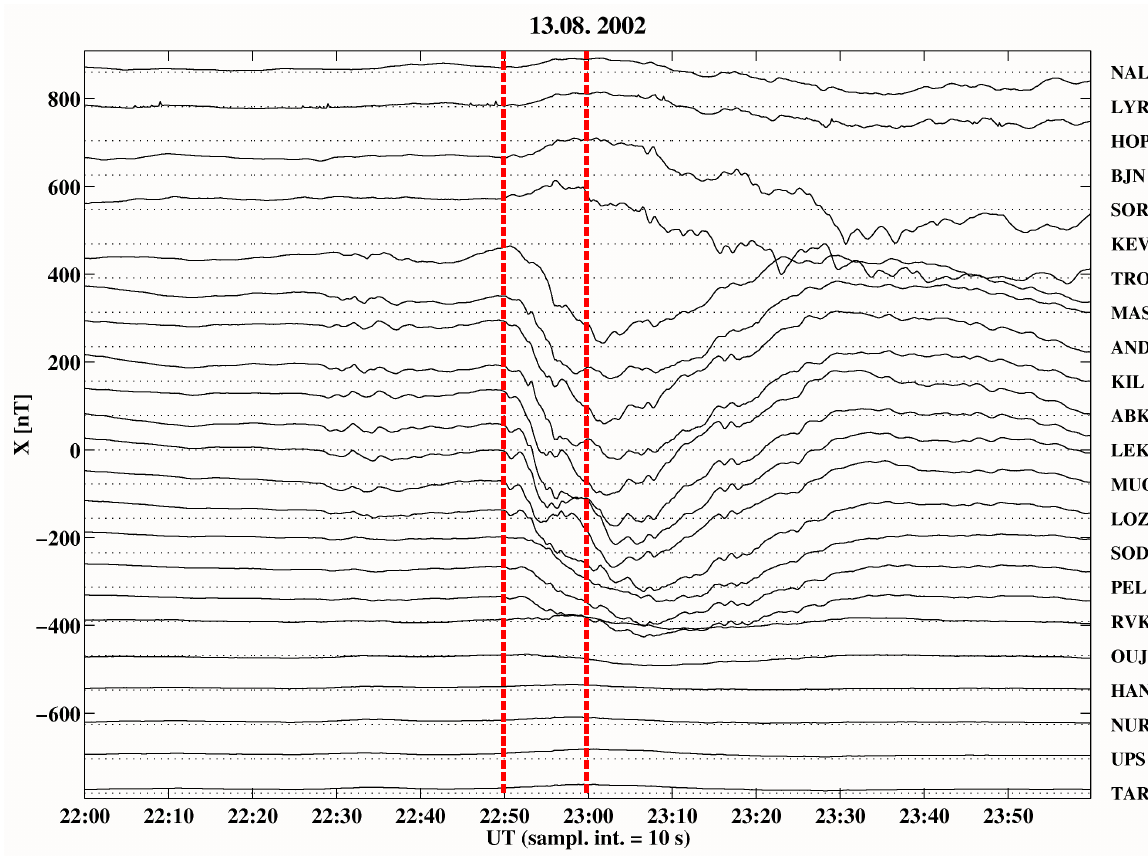
Fig. 4. Geographic north (X) component of IMAGE magnetograms on 13 August 2002, from 22:00–00:00 UT, in nT.